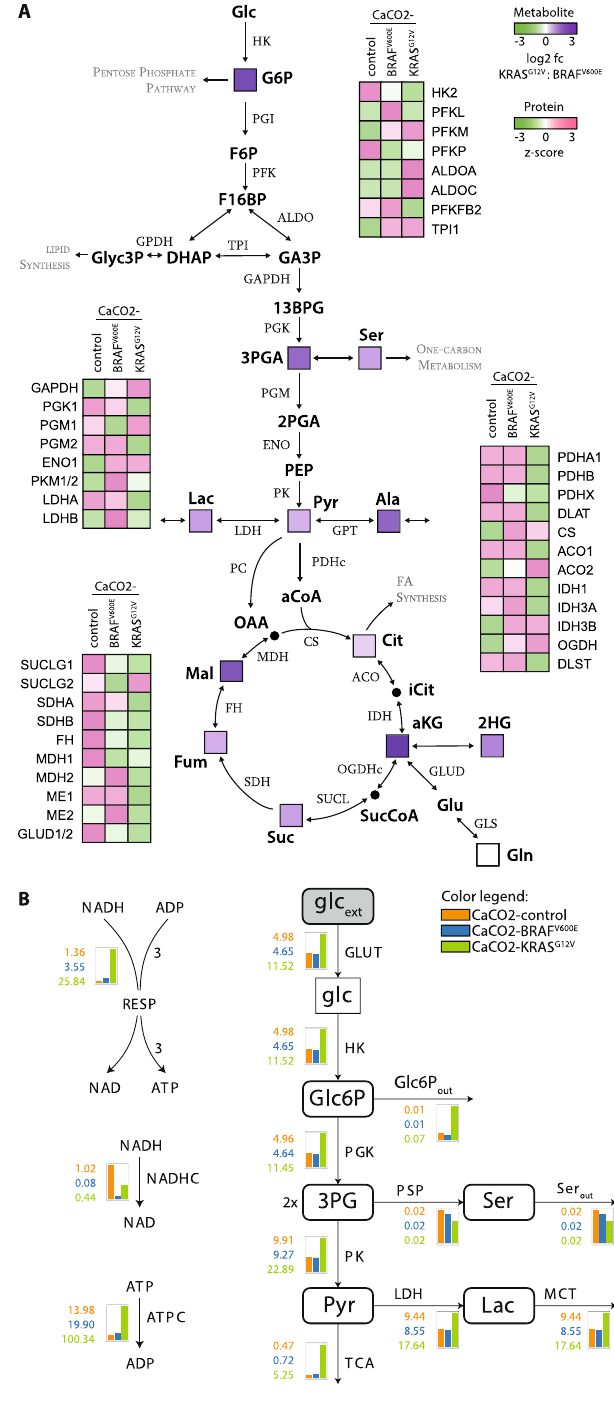
Figure 4. Cells expressing KRAS G12V were highly glycolytic and accumulated lactic acid. ( A ) CaCO2-BRAF V600E and CaCO2-KRAS G12V cells were exposed to 1.0 g/L of 13 C-glucose for 5 min, harvested and measured with GC-MS. For protein abundance, cells were measured with LC-MS. The mean ratio (log 2 fold changes, fc) of CaCO2-KRAS G12V to CaCO2-BRAF V600E for labeled metabolites and z-score of relative protein quantities are shown. ( B ) Mathematical model with the fluxes for each reaction. Species with rounded corners are species where concentration data was available. On the right side (or above) of edges are the reaction names, on the left side (or below) of the edges are the flux values of the reaction. The gray shaded node is an external species. Flux values are in µ mol/s. 3PG: 3-phosphoglycerate, Glc6P: glucose-6-phosphate, HK: hexokinase, Lac: lactic acid, PGK: phosphoglyceratekinase, PSP: phosphoserine phosphatase, Pyr: pyruvic acid, Ser: serine. glc: